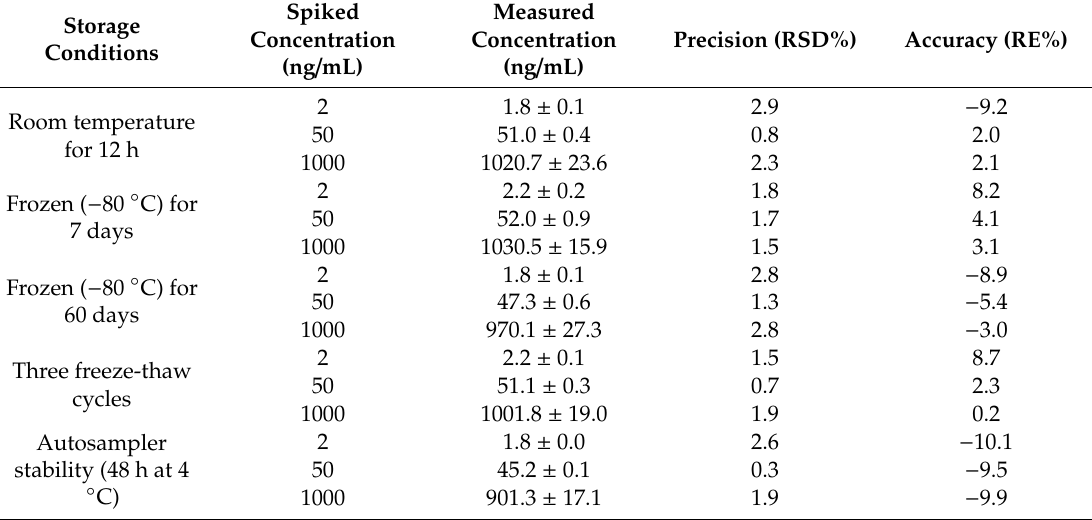
Table 4. Stability of GC20 in rat plasma under di ff erent storage conditions (n =